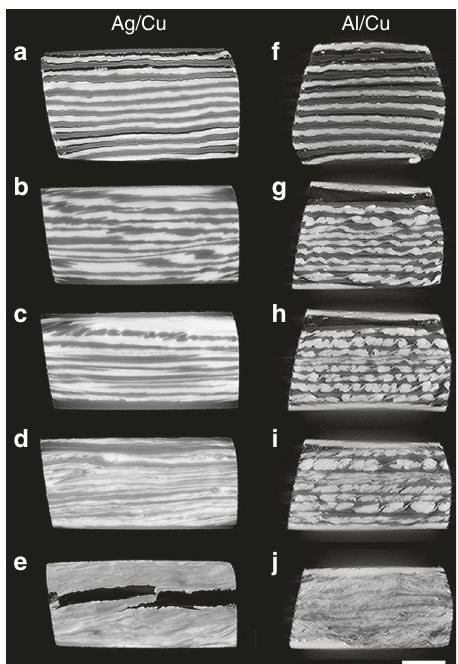
Fig. 2 Morphological evolution of multilayers upon shearing acquired by 3D X-ray synchrotron tomography. a – e Selected snapshots of Ag/Cu- multilayer sample that had been shear-deformed parallel to the layers at 1 r. p.m. for fi ve HPT revolutions, corresponding to a maximum strain of 393. The brighter phases are Ag. Here, the Cu layers predominantly delaminate before mixing at micrometer scale takes place. See Supplementary Movie 1 for the entire deformation sequence. f – j Selected snapshots of the Al/Cu- multilayer sample, shear-deformed parallel to the layers at 1 r.p.m. for three HPT revolutions, corresponding to a maximum strain of 236. The brighter phases are Cu. Here, the Cu layers initially fold in a quasi-regular manner and subsequently evolve into periodic vortices, before mixing at micrometer scale takes place. See Supplementary Movie 2 for the whole